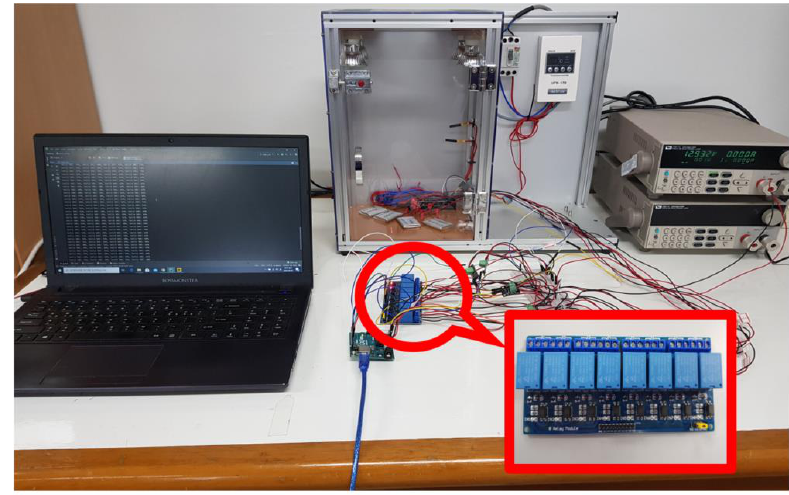
Figure 5. Experimental environment for real-time SOC estimation.